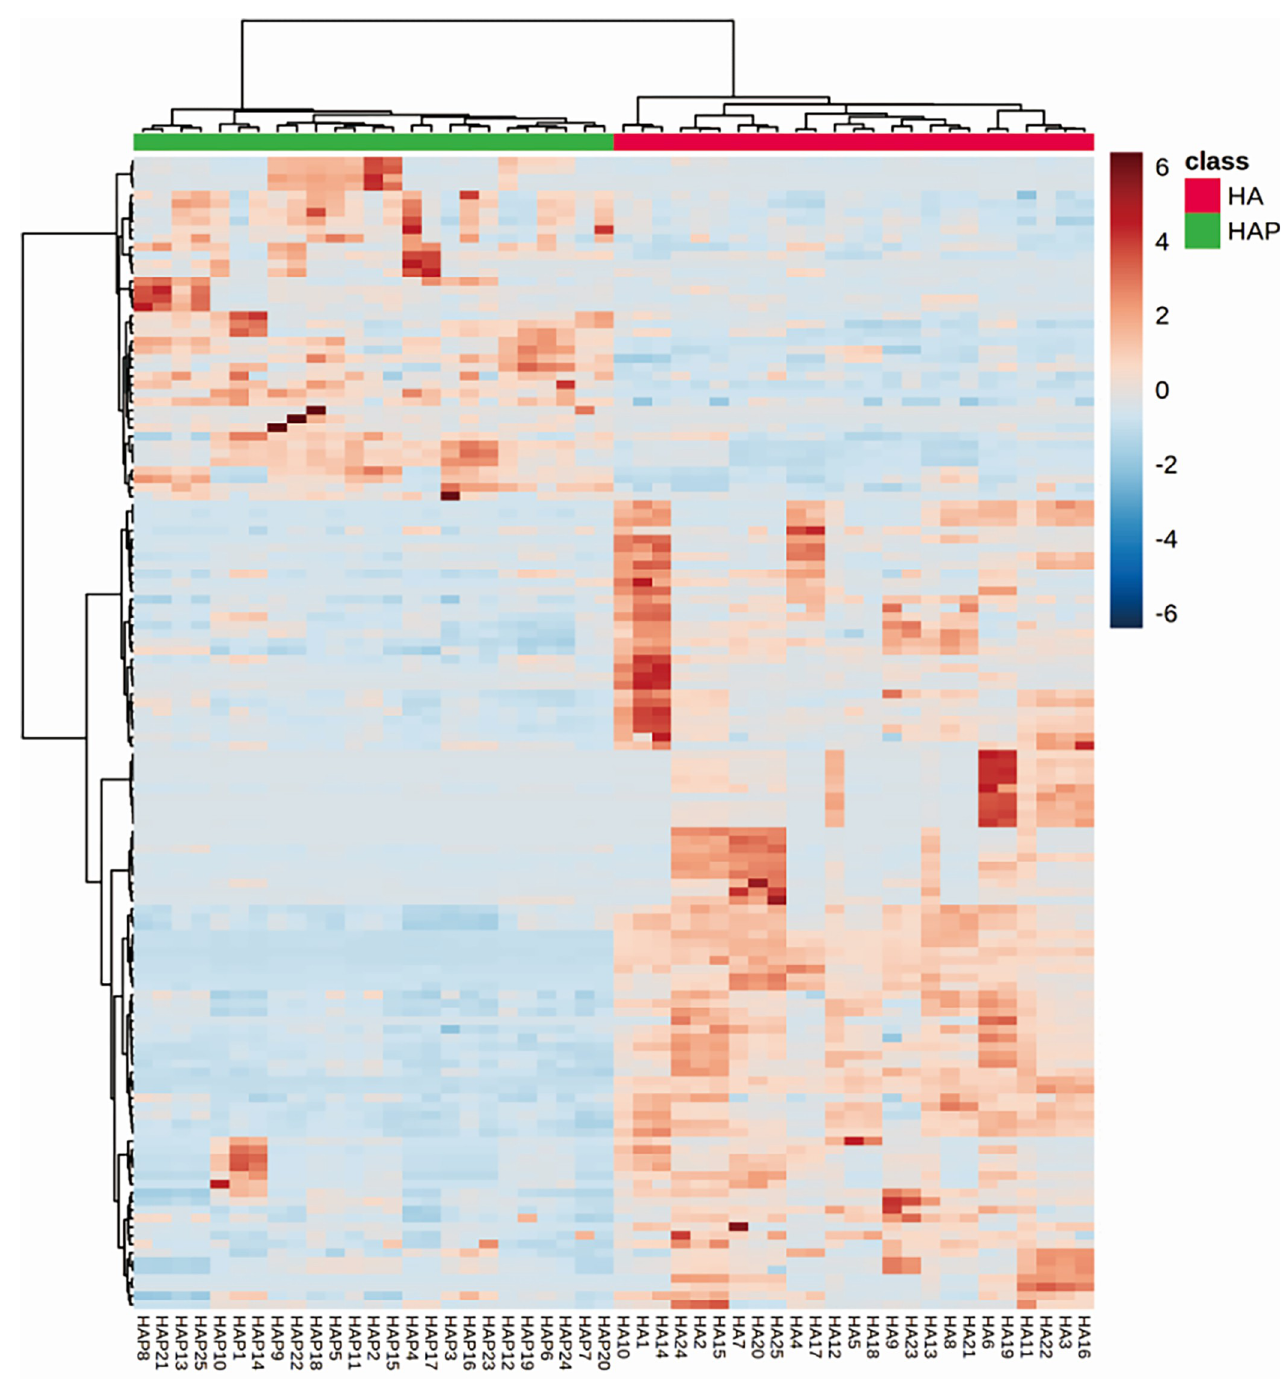
Fig 5. Heat map of the differential metabolites between HA and HAP